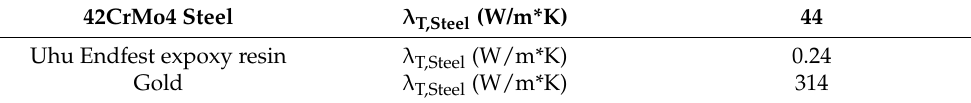
Table 5. Thermal conductivity of 42CrMo4 steel, epoxy insulation layer, and thermocouple elec- trodes.